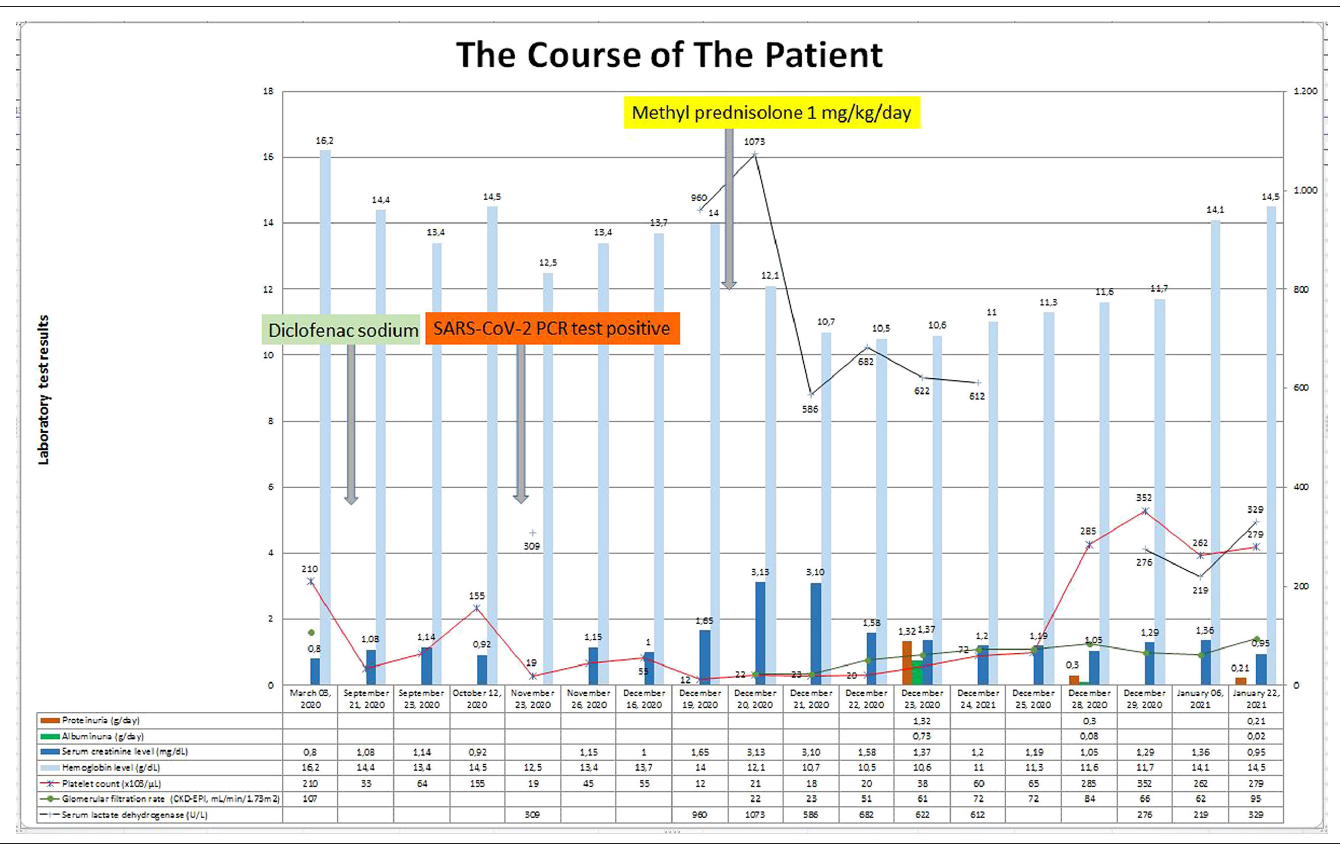
Figure 1. The course of serum hemoglobin, creatinine, thrombocyte, lactate dehydrogenase levels, and proteinuria, albuminuria, and glomerular filtration rate results of the